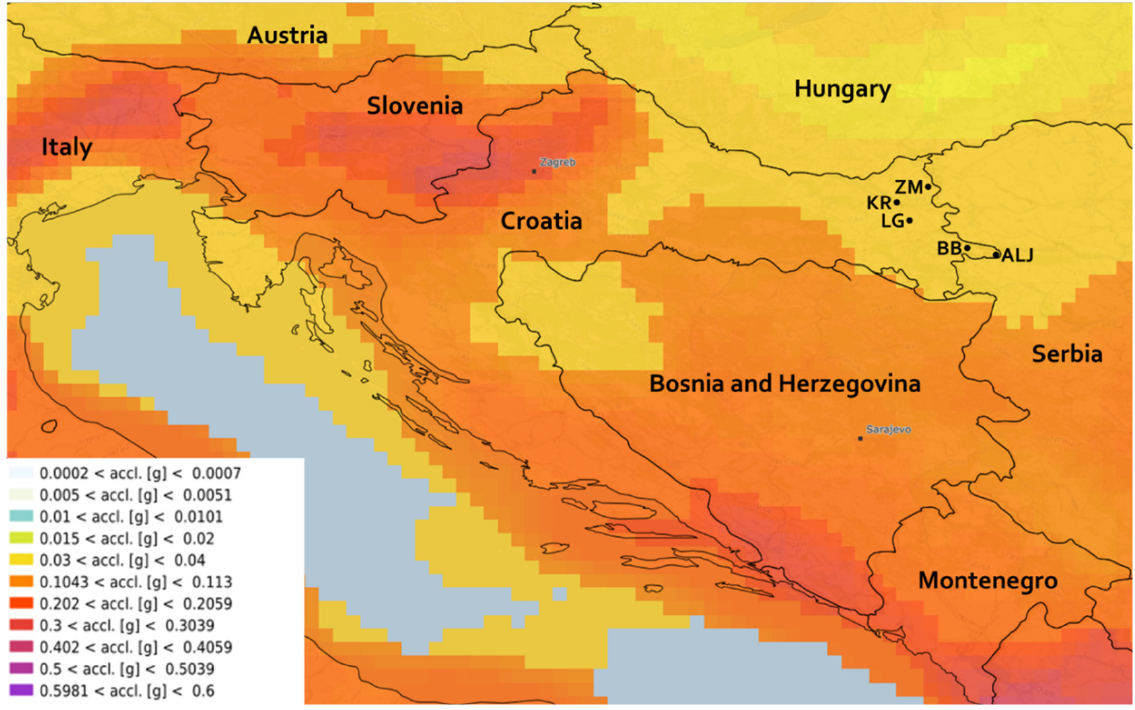
Figure 2. The earthquake hazard map of Croatia and bordering countries [27] with markings of the places from which the rammed earth samples observed in this work were taken: Aljmaš (ALJ), Bijelo Brdo (BB), Karanac (KR), Lug (LG) and Zmajevac